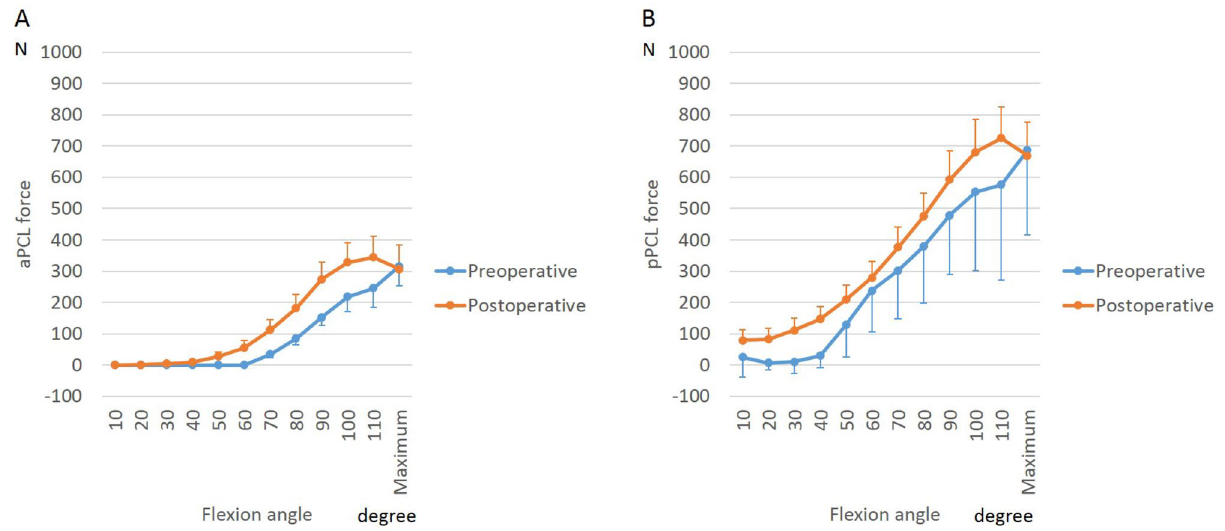
Figure 7. Posterior cruciate ligament (PCL) force during squatting before and after bicruciate-retaining total knee arthroplasty: ( A ) Anterolateral bundle of the PCL (aPCL); ( B ) Posteromedial bundle of the PCL